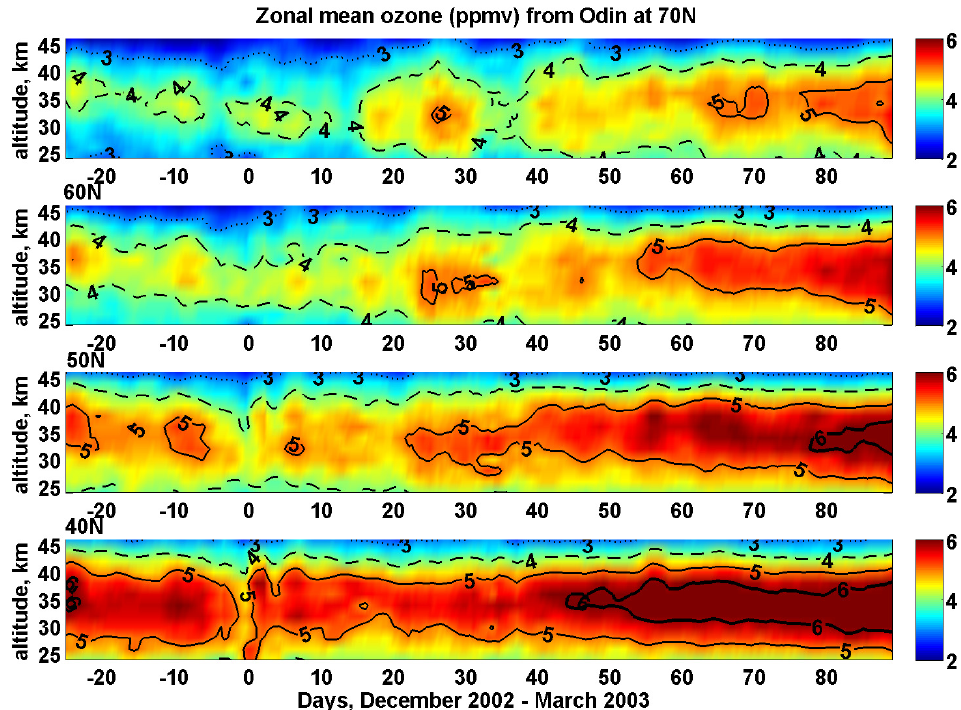
Fig. 2. Zonal means of ozone mixing ratio (ppmv) from Odin SMR data at 70 ◦ N, 60 ◦ N, 50 ◦ N, 40 ◦